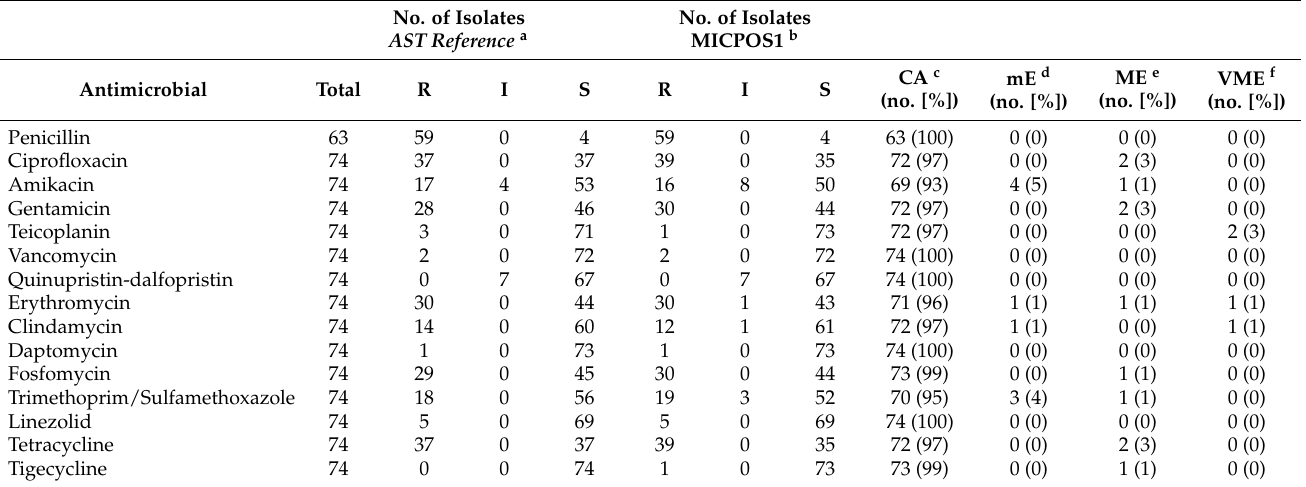
Table 2. Results for Staphylococci tested with the MICPOS1 standard turbidity inoculum method and visual reading versus AST reference